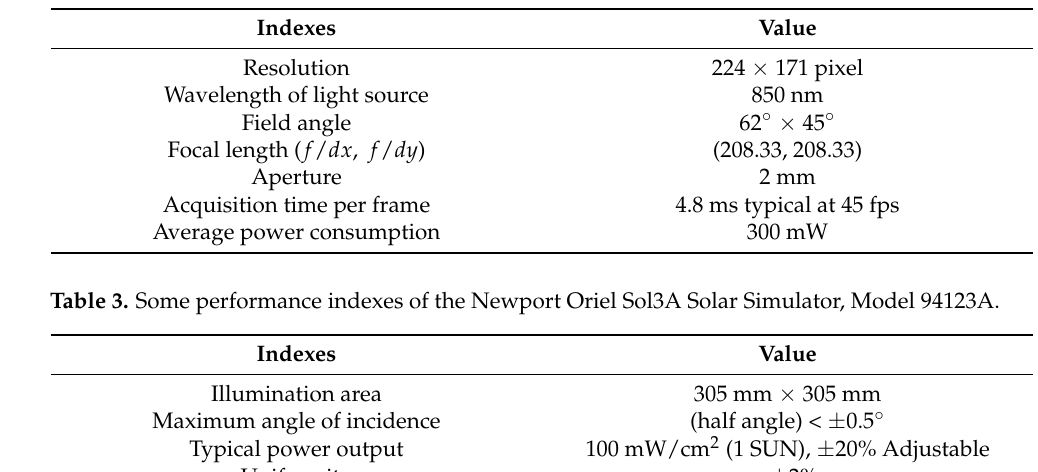
Figure 13. Ground experiment scene. ( a ) Schematic diagram of the ground experiment scene; ( b ) actual ground experiment scene; ( c ) the Newport Oriel Sol3A Solar Simulator, Model 94123A. Table 2. The performance indexes of PMD CamBoard.